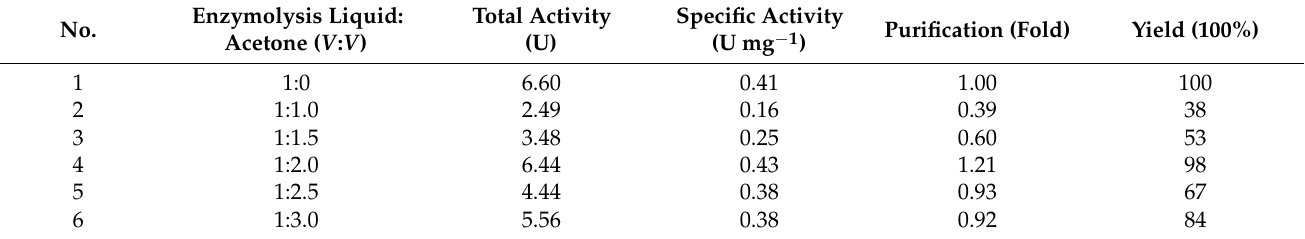
Table 1. Summary of purification of fucoidanase via acetone